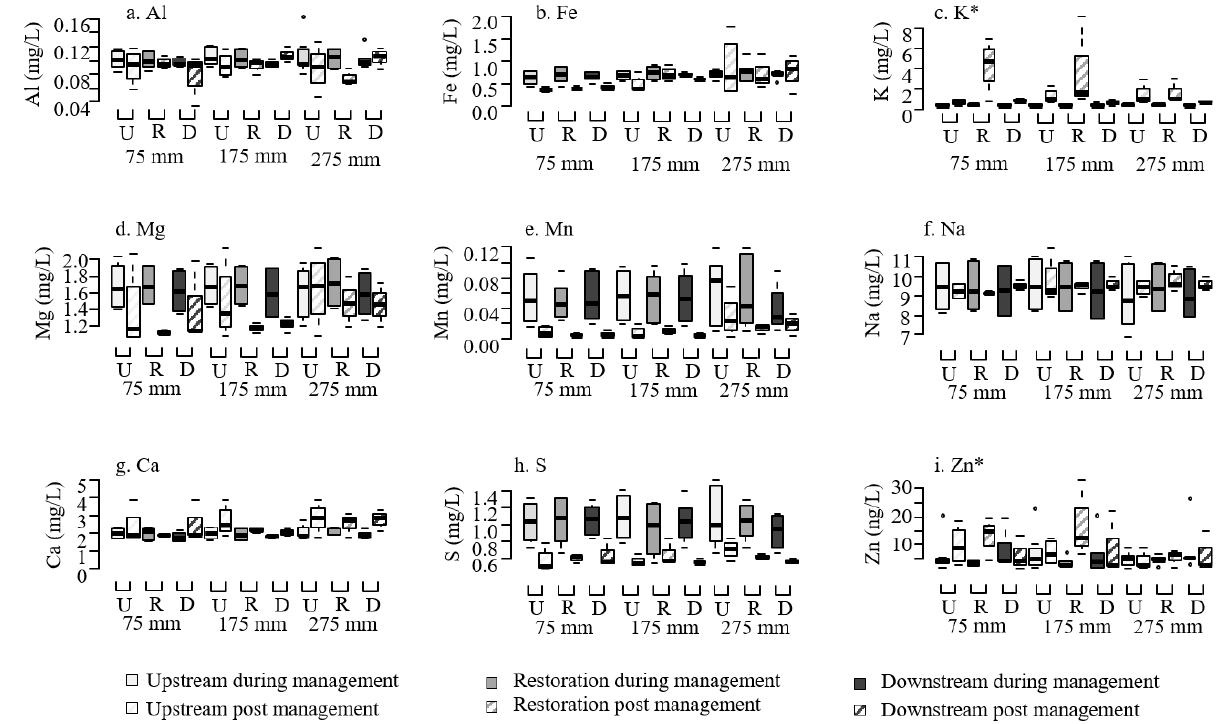
Figure 4. Concentration of elements (Al, Fe, K, Mg, Mn, Na, Ca, S, Zn) in the water taken at depths of 75, 175 and 275 mm in the streambed during (shaded boxes) and one year after restoration (hashed shaded boxes) upstream of (U, light grey), within (R, dark grey) and downstream of (D, black) the restoration management areas. Within U, R and D, bars are in pairs; the first is during management and the second after management. Elements followed by a * indicate a significant effect of restoration management. Note the change of units for